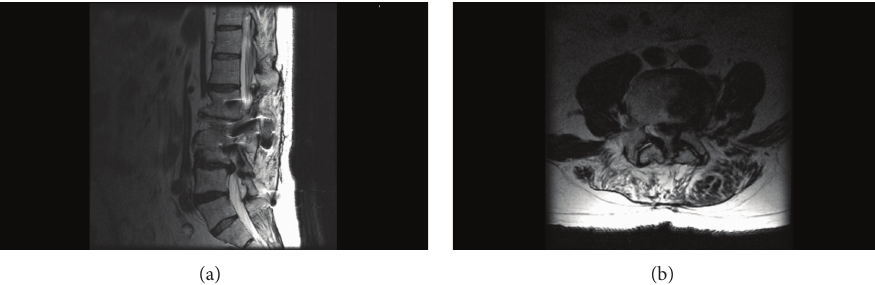
Figure 1: Sagittal (a) and axial (b) T2 weighted MRI scan of the lumbar spine displaying segment degeneration adjacent to a previous instrumented fusion with disc herniation as well as facet and ligamentum flavum hypertrophy.